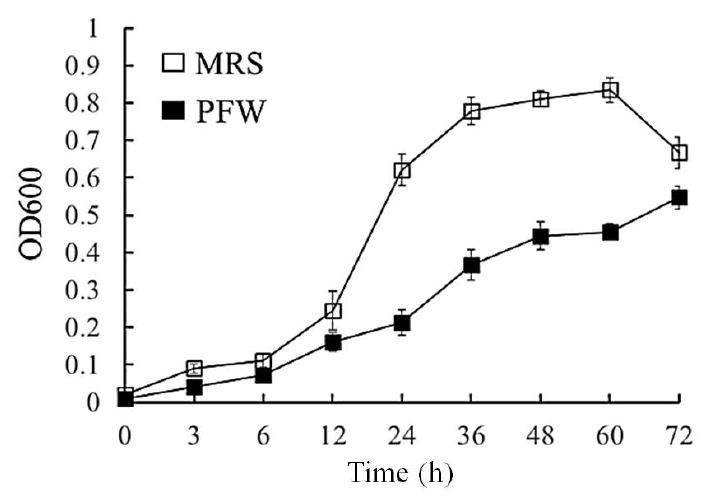
Figure 1. Growth curves of Lactobacillus plantarum grown in MRS medium or PFW solution at 3, 6, 12, 24, 36, 48, 60, and 72 h of incubation. Data were expressed as mean ± standard error of the mean (SEM).